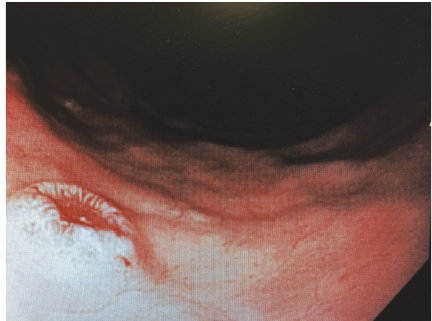
Figure 1: Malignant appearing gastric ulcer during endoscopic evaluation.